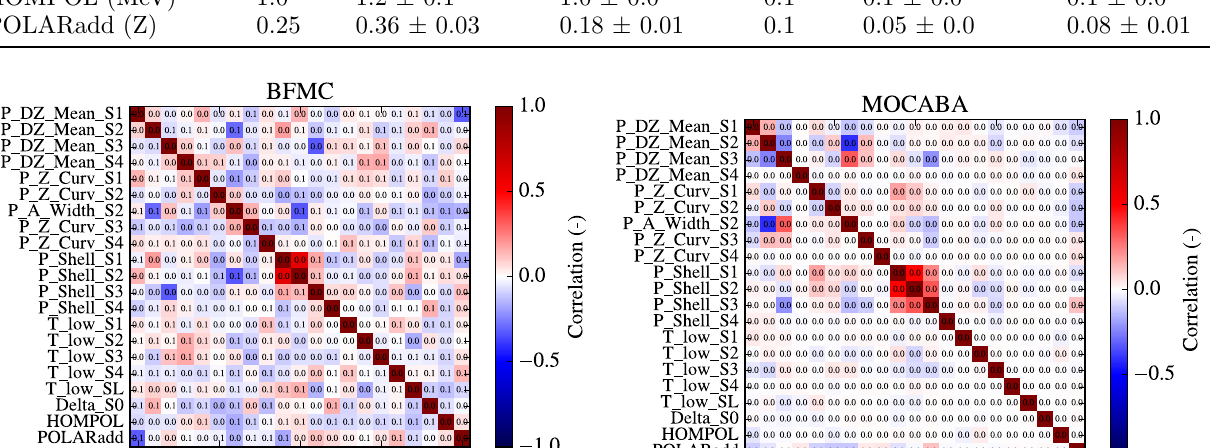
Fig. 12. Correlations between the model parameters when MLO is not used. Each correlation coefficient has its 95%-bootstrap- confidence interval over-laid on it.